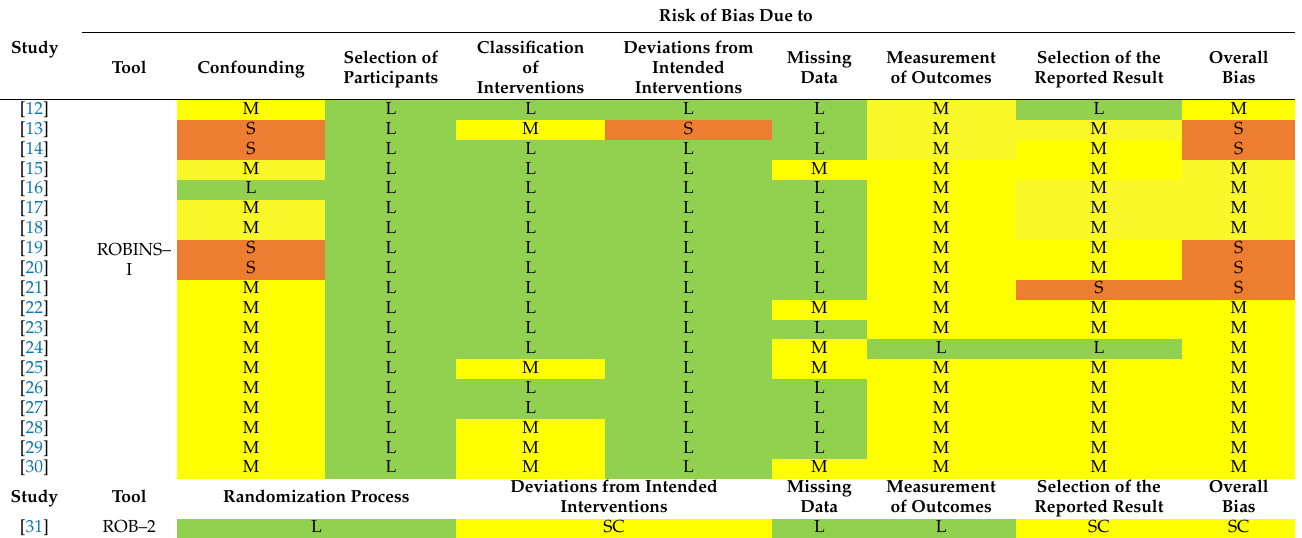
Table 1. Quality assessment of the